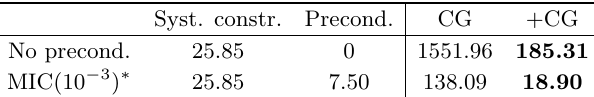
Division of CPU time between system construction, preconditioning and system resolution, for the 4096 2 example. Knowing that the system and the preconditioner can often be pre- computed, this makes even more obvious the gain one can expect by choosing an appropriate initialisation such as the FM result. CG refers to the resolution of the system by conjugate gradient, and +CG to accelerated resolution by using FM initialisation (time does not include the 21 . 79 s required for FM) Syst. constr. Precond.